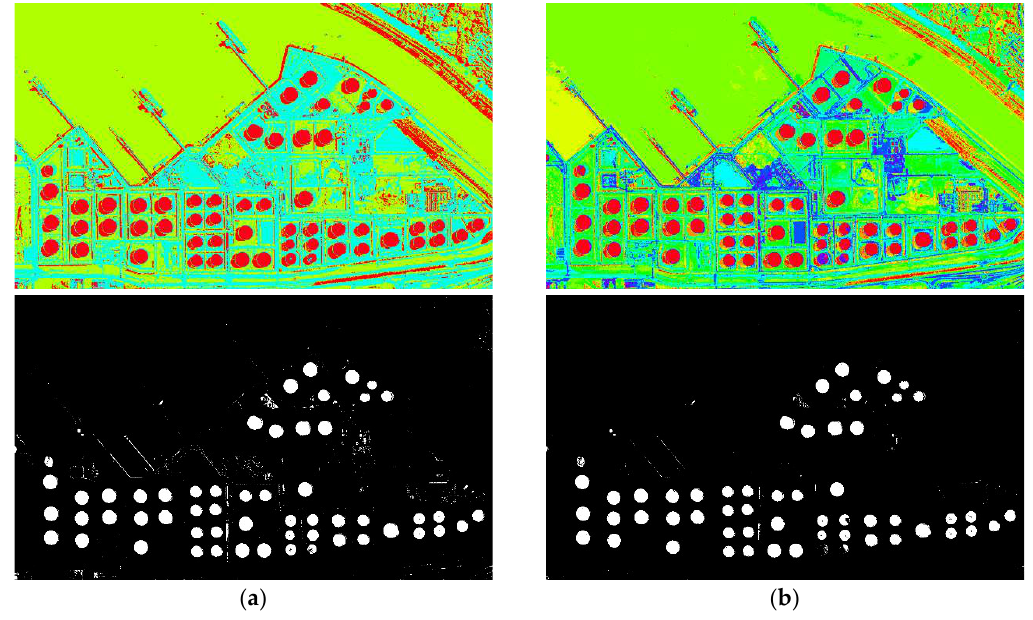
Figure 9. The segmentation results of the Image a. ( a ) 3-level thresholding; ( b ) 9-level thresholding.